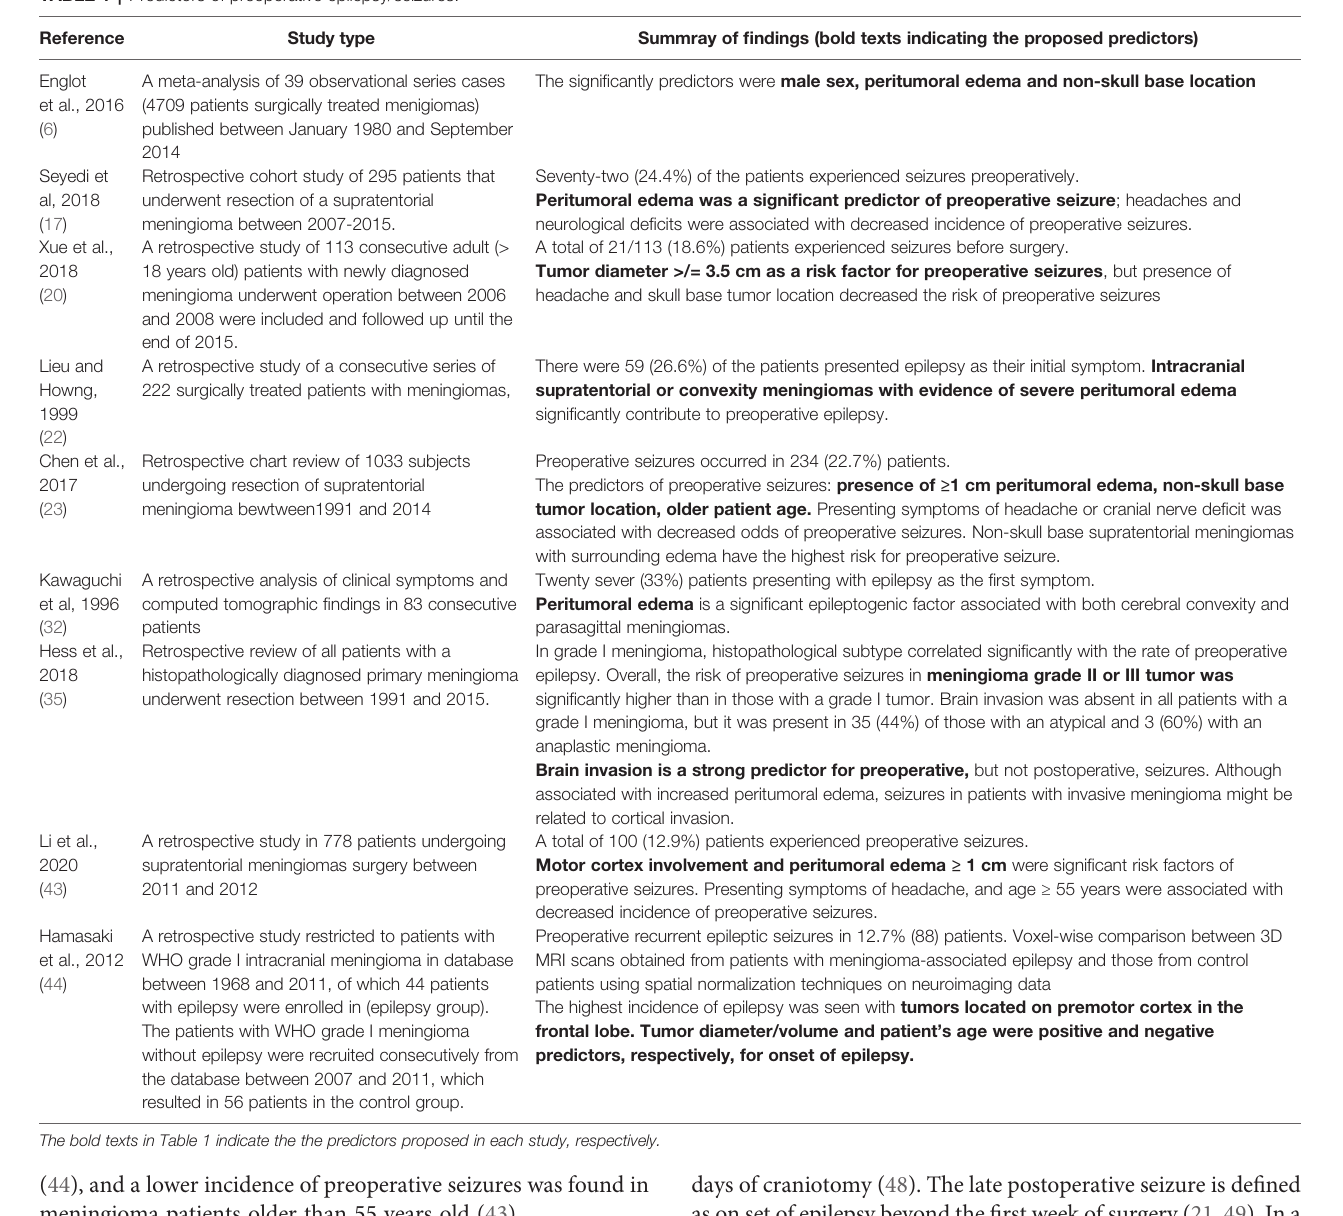
TABLE 1 | Predictors of preoperative